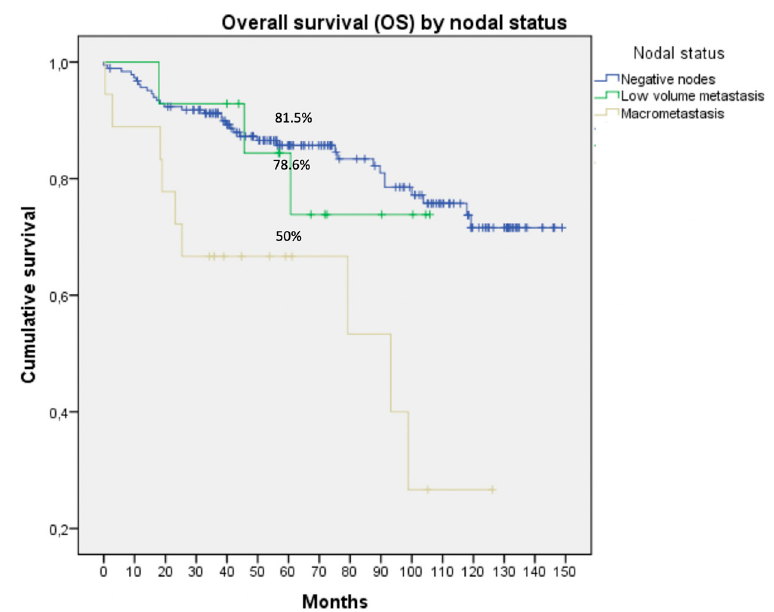
Figure 1. Progression-free survival by nodal status in patients with nodal surgical staging. Significant differences were observed between groups in 5-year PFS ( p = 0.018).